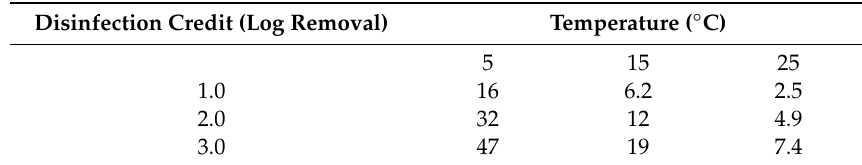
Table 7. Disinfection credits and CT values in mg-min / L for inactivation of Cryptosporidium by ozone, as noted by the USEPA, 2003. [179].